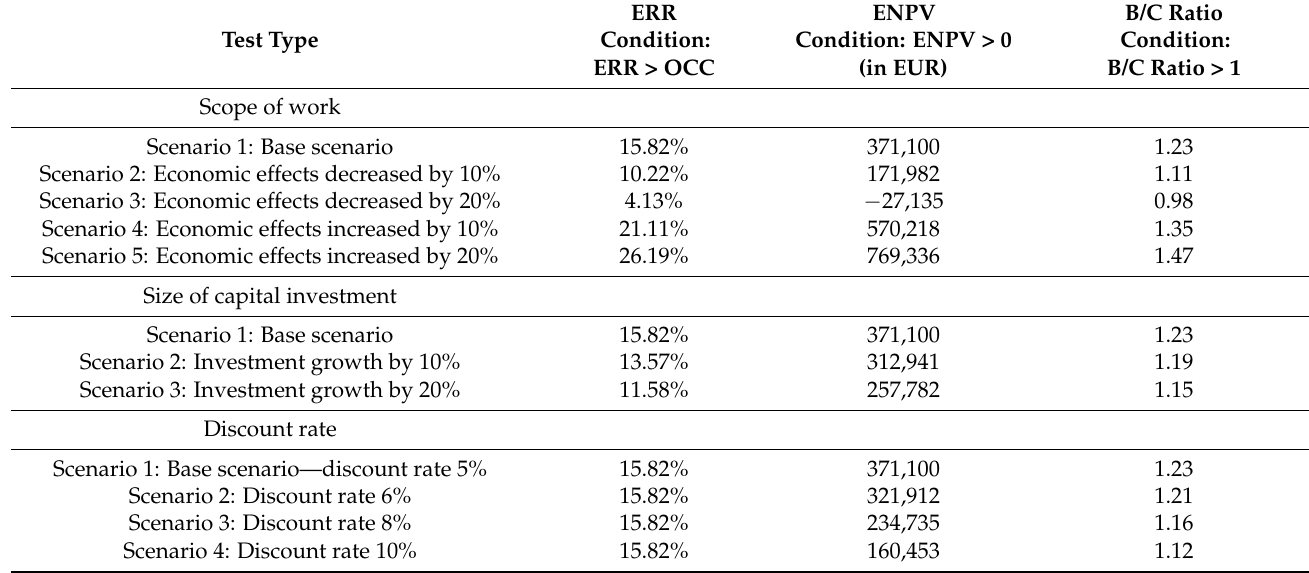
Table 15. Project sensitivity analysis